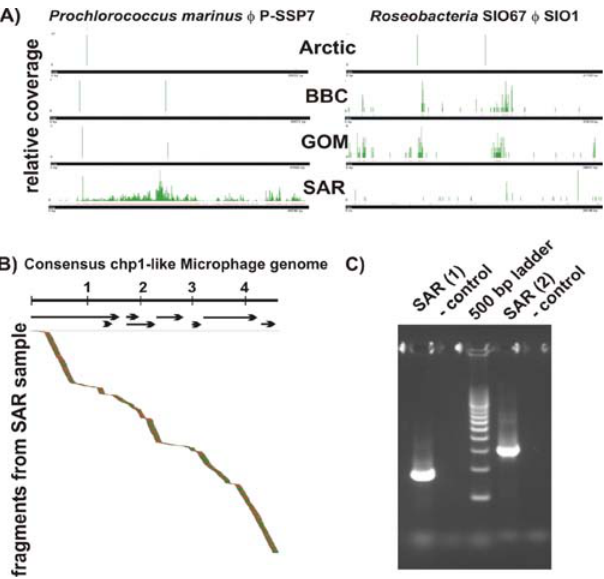
Figure 3. Distribution of Similarities and Assembly Controls (A) Distribution of similarities between the four metagenome samples to the P. marinus / P-SSP7 and Roseobacteria SIO67 / SIO1 genomes (as determined by BLASTN analysis). The green bars represent the average number of sequences averaged over 100 bp windows. (B) Comparison of fragments from the Sargasso Sea metagenome against the consensus ssDNA chp1-like microphage genome. The consensus from this assembly is in the Protocol S1. (C) PCR verification of chp1-like microphages in original SAR sample. PCR primers were designed based on a consensus sequence from the assembly shown in (B). SAR1 is a ; 900-bp fragment and SAR2 is a ; 1,500-bp fragment. DOI: